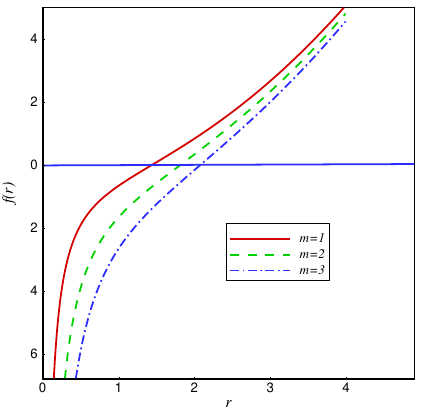
Figure 1 . The behavior of f ( r ) for rotating black string with (cid:3) = 1.